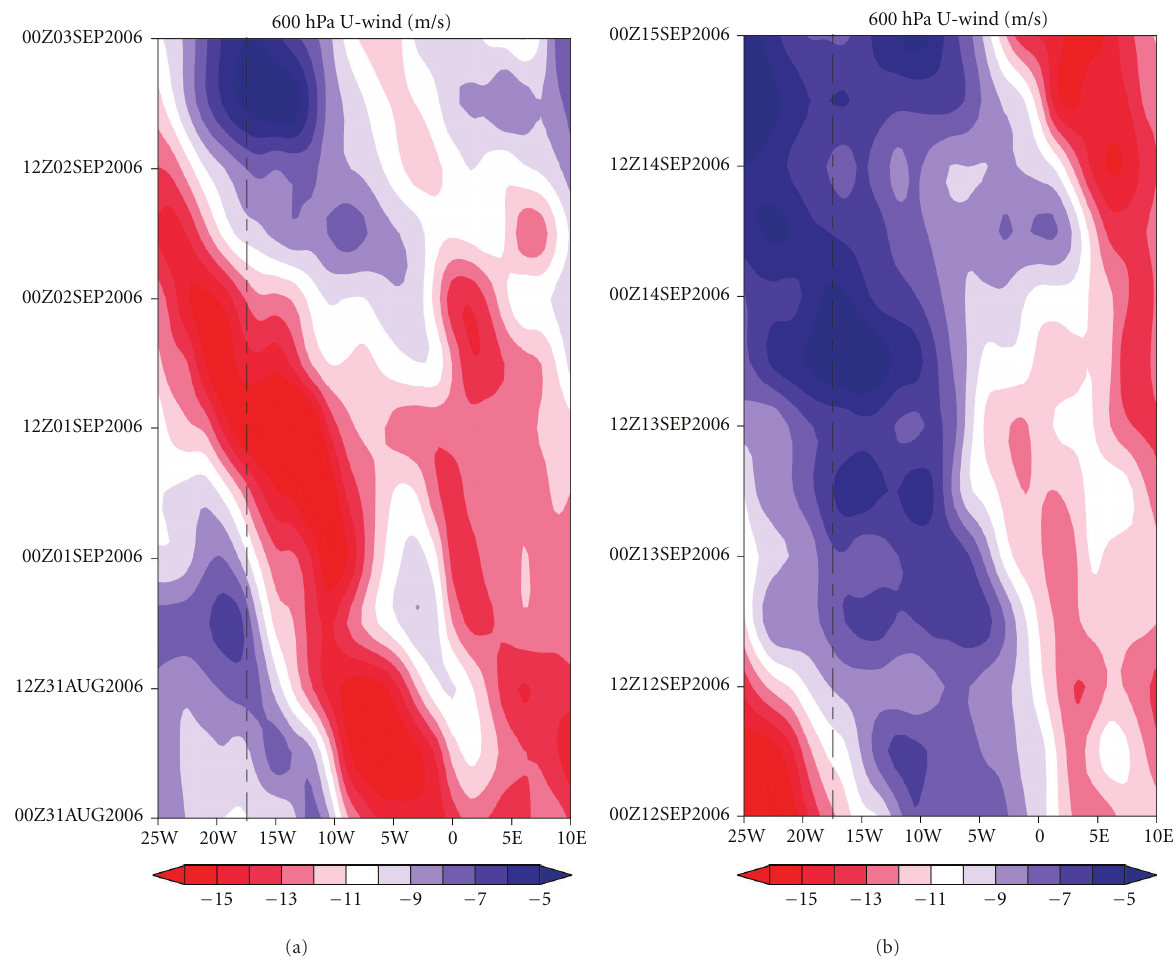
Figure 2: Zonal wind component (ms − 1 ) at 600 hPa plotted over a three-day period as a function of longitude for the most representative (see Table 1) TCP system (a) and the most representative NTCP system (b). The zonal winds have been averaged over a latitude range from 10 ◦ N to 20 ◦ N. The darker red colors indicate larger easterly wind speeds, and darker blue colors indicate weaker easterlies. The black dashed line indicates the longitude of